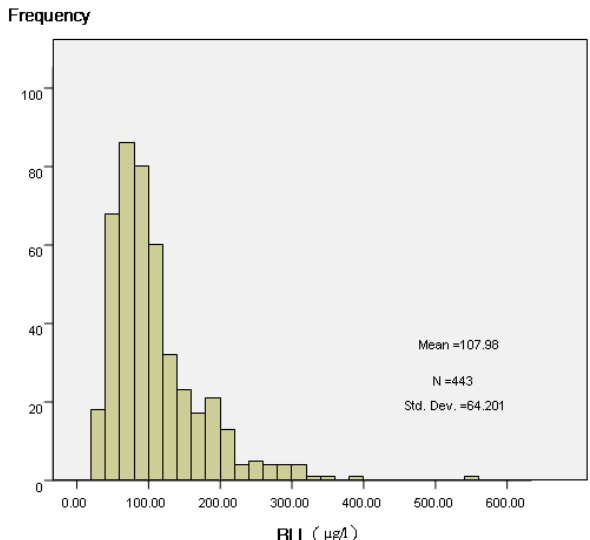
Figure 2. Frequency distribution of children’s BLL (a: measurement data). Table 4. Determinant of blood lead as assessed by multiple regression analysis.